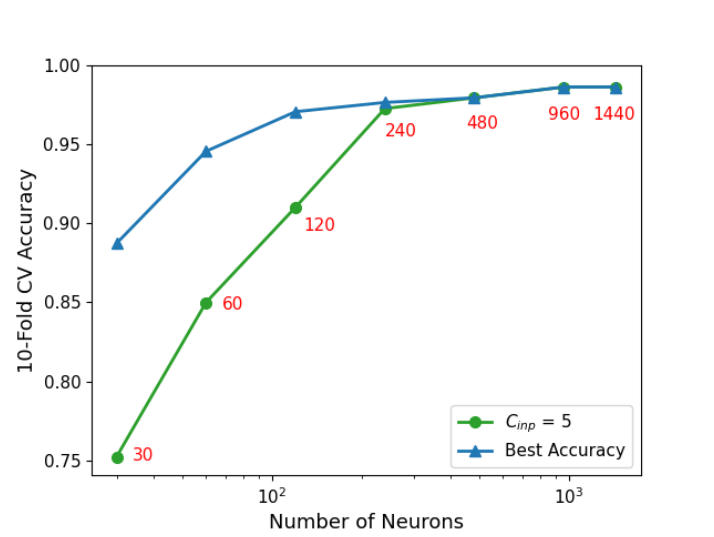
Figure 14. The 10-fold cross-validation accuracy vs. LSM size. Red numbers indicate the exact number of neurons in the network. Green curves follow the accuracy at a fix C inp = 5. The blue curve gives the best accuracy irrespective of C inp for the given LSM size.